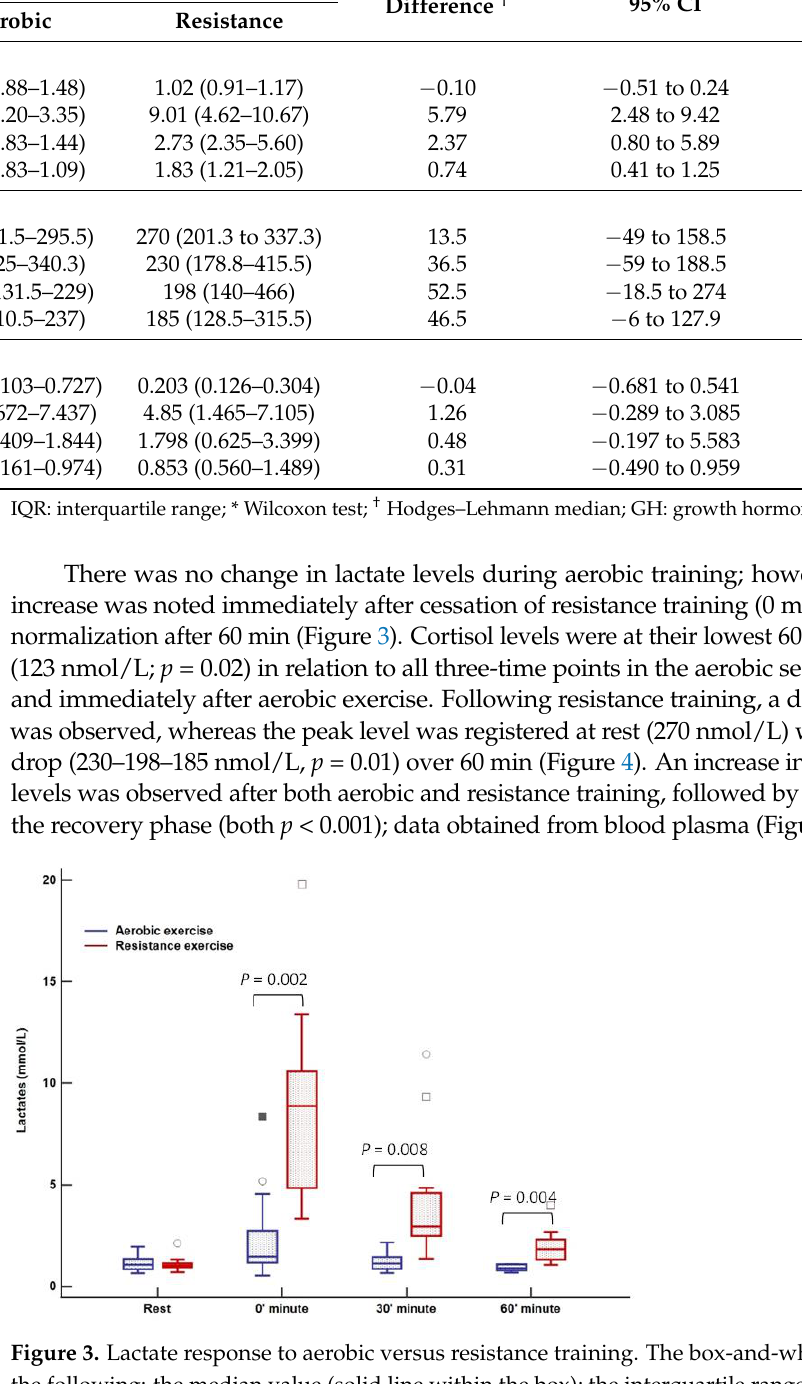
Table 6. Lactate, cortisol, and GH response to aerobic versus resistance training.